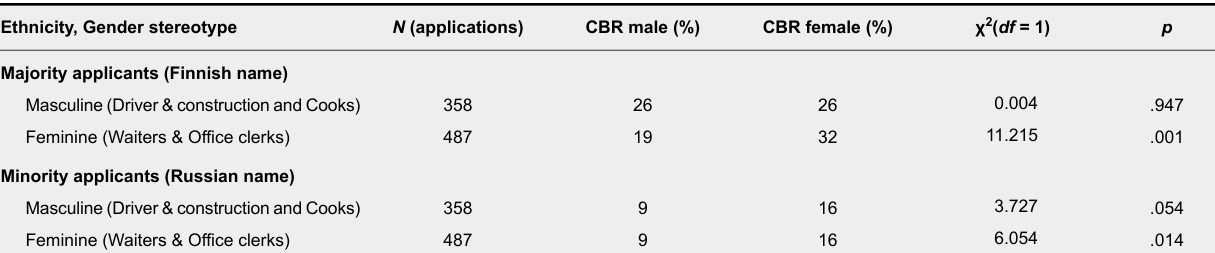
Discrimination Based on Gender and Ethnicity: Call-Back Rates (CBR) in the 2 nd